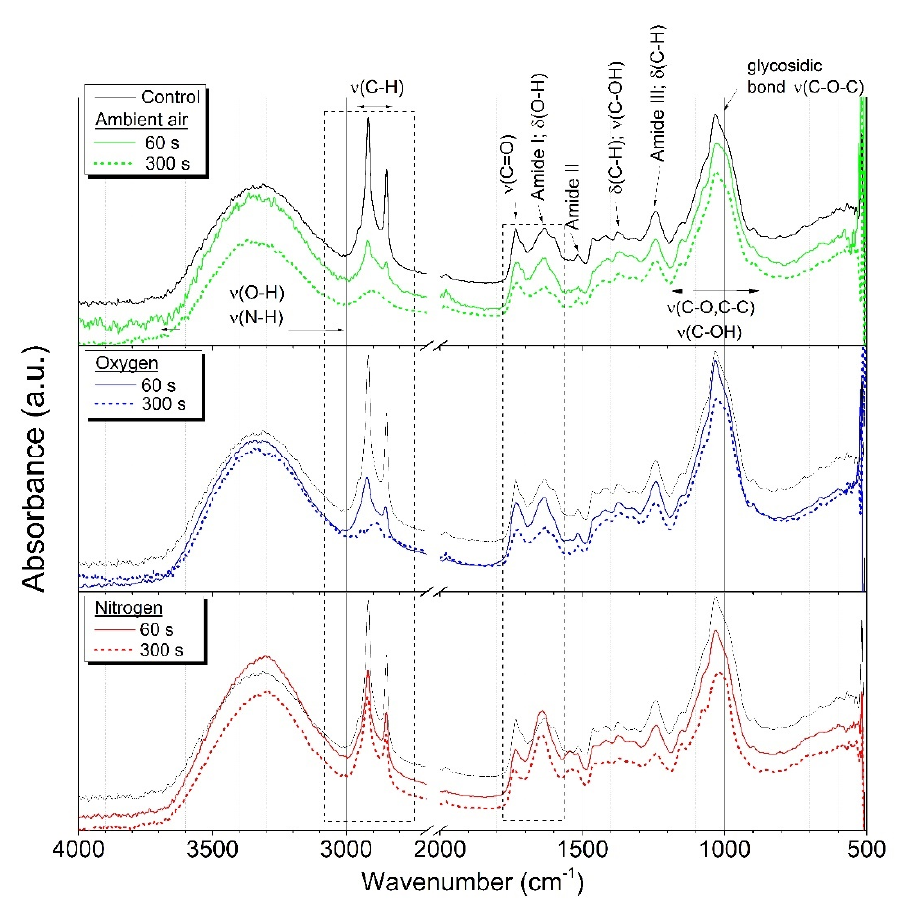
Figure 1. Attenuated Total Reflectance-Fourier Transform Infrared spectroscopy (ATR-FTIR) spectra of maize grains untreated and after plasma treatment in ambient air, oxygen and nitrogen, treatment time 60 s, 300 s, at input power 400 W.